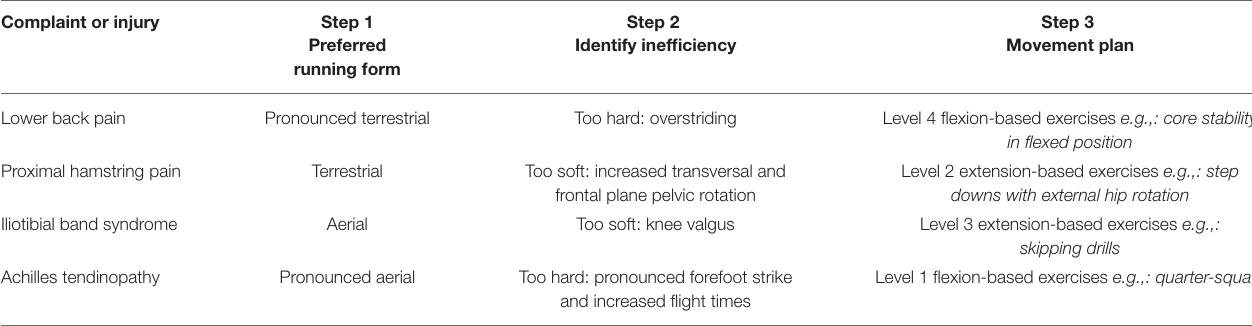
TABLE 2 | Four examples of the application of the PIMP approach. Complaint or